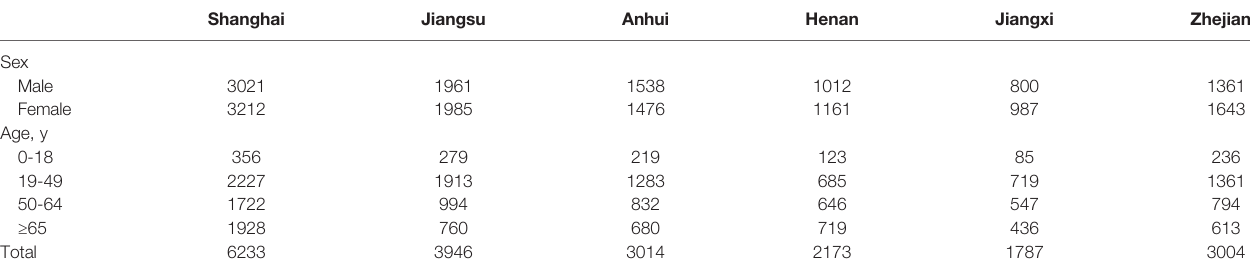
TABLE 1 | Number of clinical specimens for antibodies to SARS-CoV-2 in six districts.